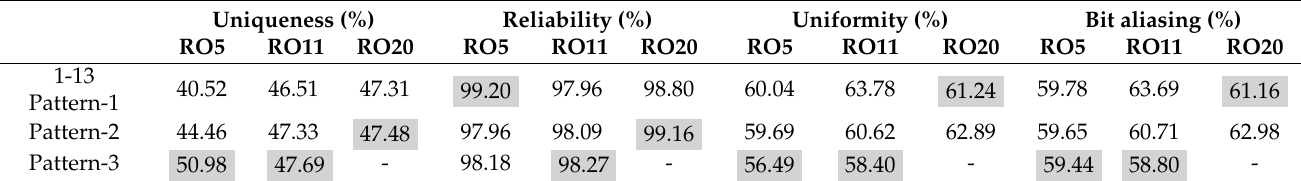
Table 4. Ring oscillator performance of all patterns and all